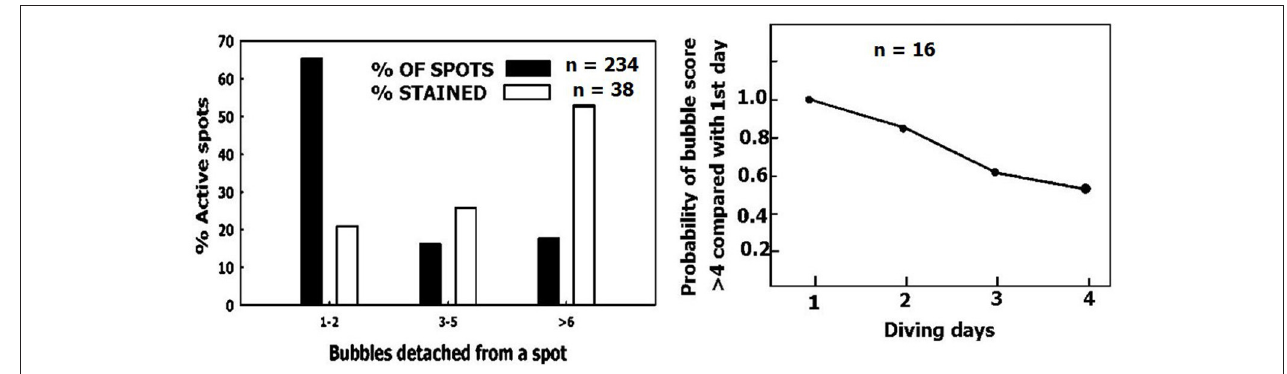
FIGURE 9 | Removal of small sized AHS. (Left) Distribution of AHS (black columns) and the distribution of AHS staining positive for lipids (empty columns), as a function of their bubble production. (Right) The odds ratio value of having a higher bubble score over 4 consecutive days of diving compared with day 1 (adapted from Zanchi et al., 2014 with permission).